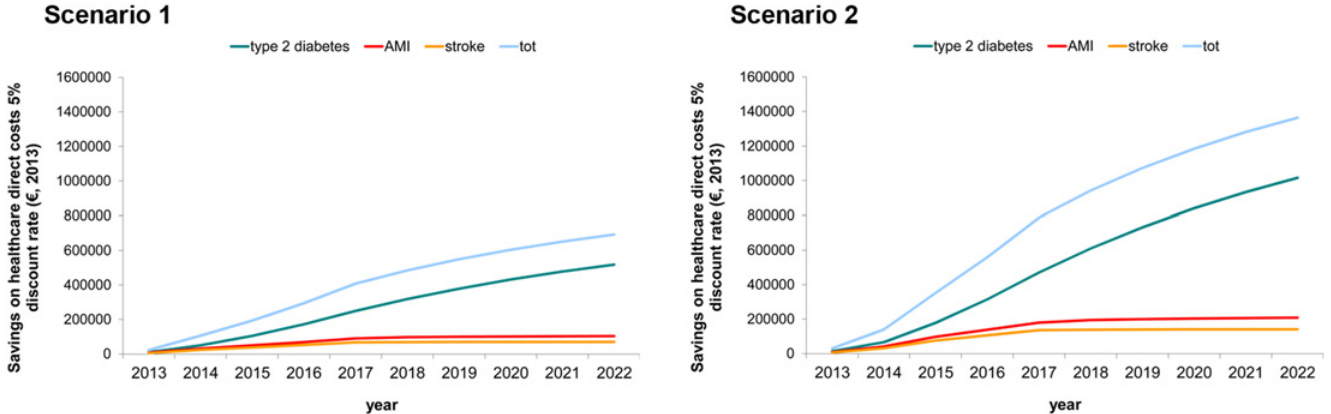
Fig 4. Potential yearly discounted savings on healthcare direct costs by year and health outcome, 5% discount rate ( € , 2013). Scenario 1: Less ambitious cycling promotion target; Scenario 2: Optimistic cycling promotion target.